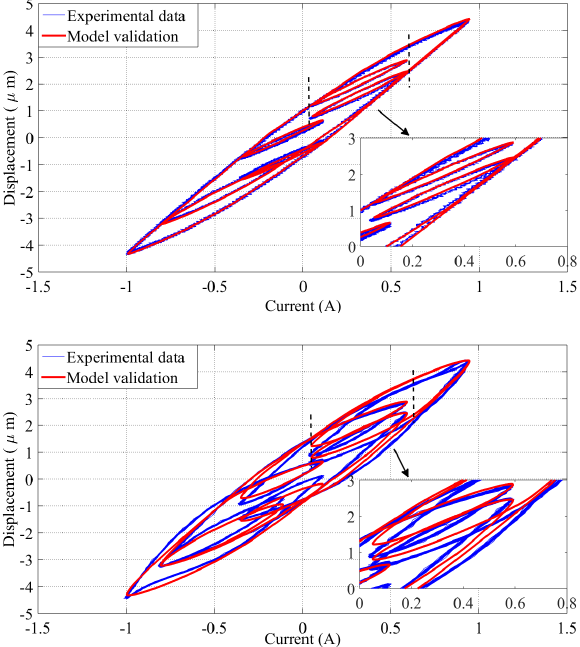
Figure 12. Minor loop responses between the proposed model and experiment data with f 0 = 1 and f 0 =